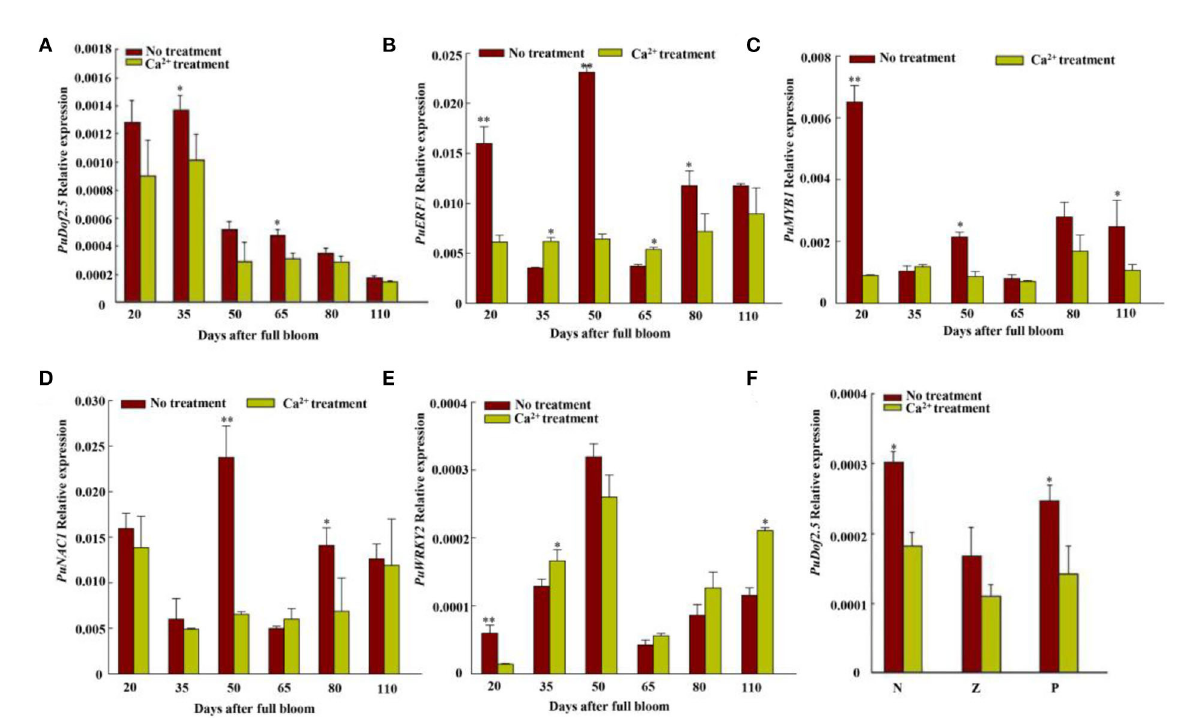
FIGURE4 Transcriptome-filtered transcription factor expression level analyses of Nanguo pear fruits. (A) Expression level of PuDof2.5 at six fruit developmental stages after Ca 2 + treatment. (B) Expression level of PuERF1 at six fruit developmental stages after Ca 2 + treatment. (C) Expression level of PuMYB1 at six fruit developmental stages after Ca 2 + treatment. (D) Expression level of PuNAC1 at six fruit developmental stages after Ca 2 + treatment. (E) Expression level of PuWRKY2 at six fruit developmental stages after Ca 2 + treatment. (F) PuDof2.5 expression in different pear tissues. N, flesh close to the pit; Z, flesh in the middle; P, flesh close to the fruit skin. Data are shown as mean ± SE (n = 3). Statistical significance was determined by Student’s t -test: * P < 0.05, ** P <